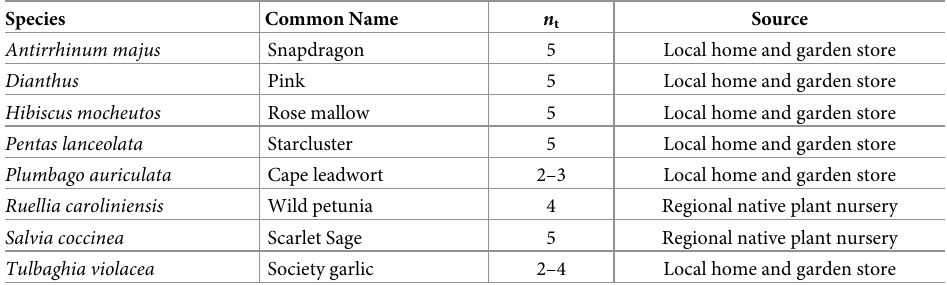
Table 1. Plant species and sample sizes per treatment ( n t ) for greenhouse studies.